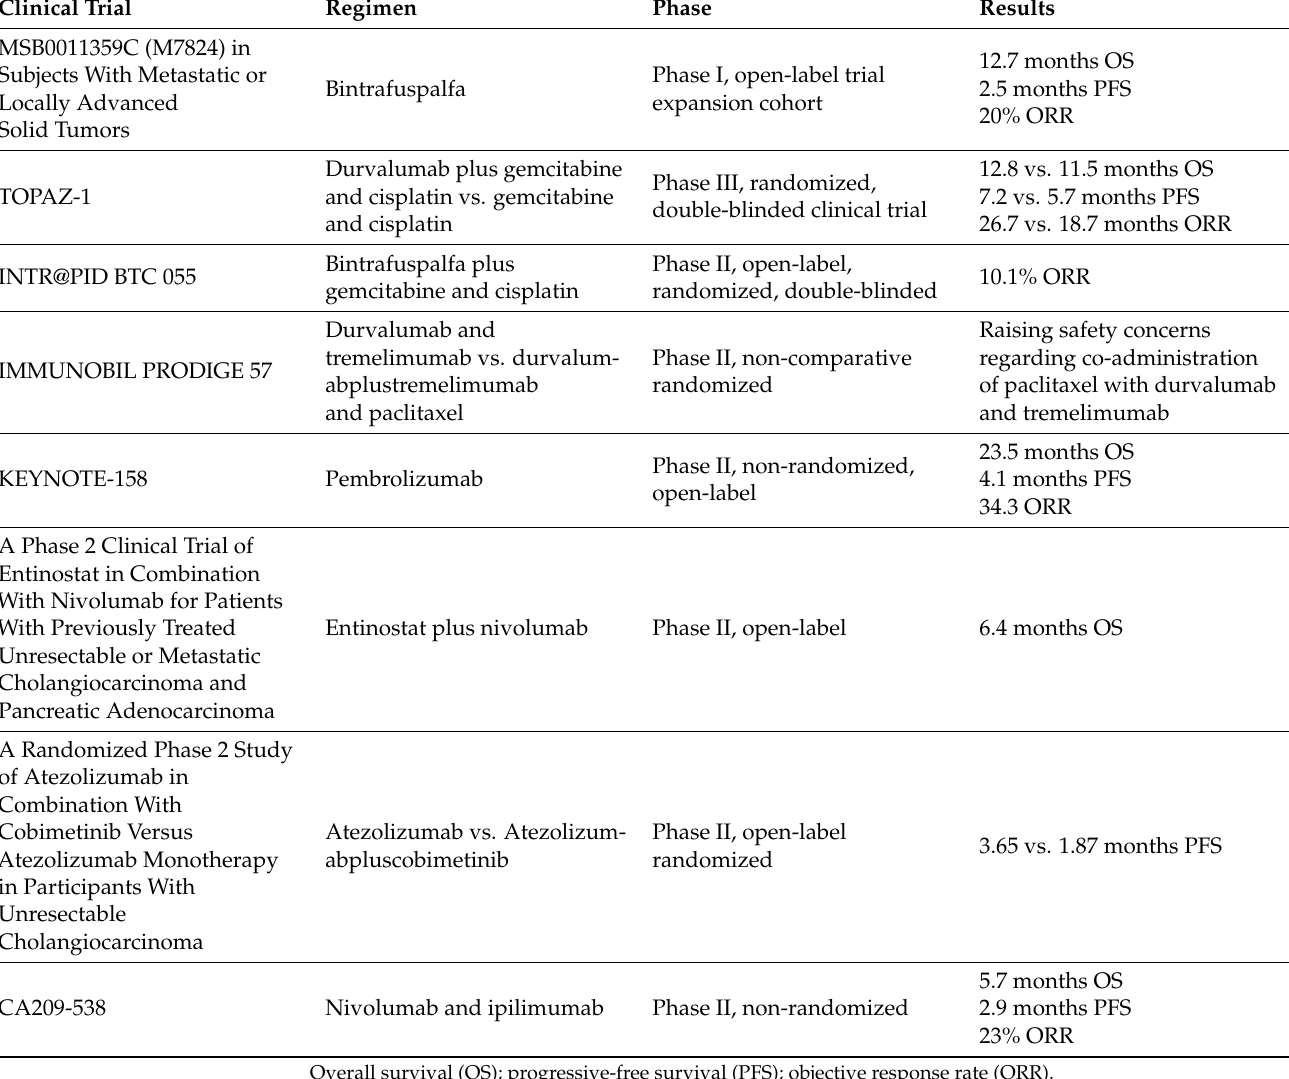
Table 2. Summary of the results from clinical trials in CCA with